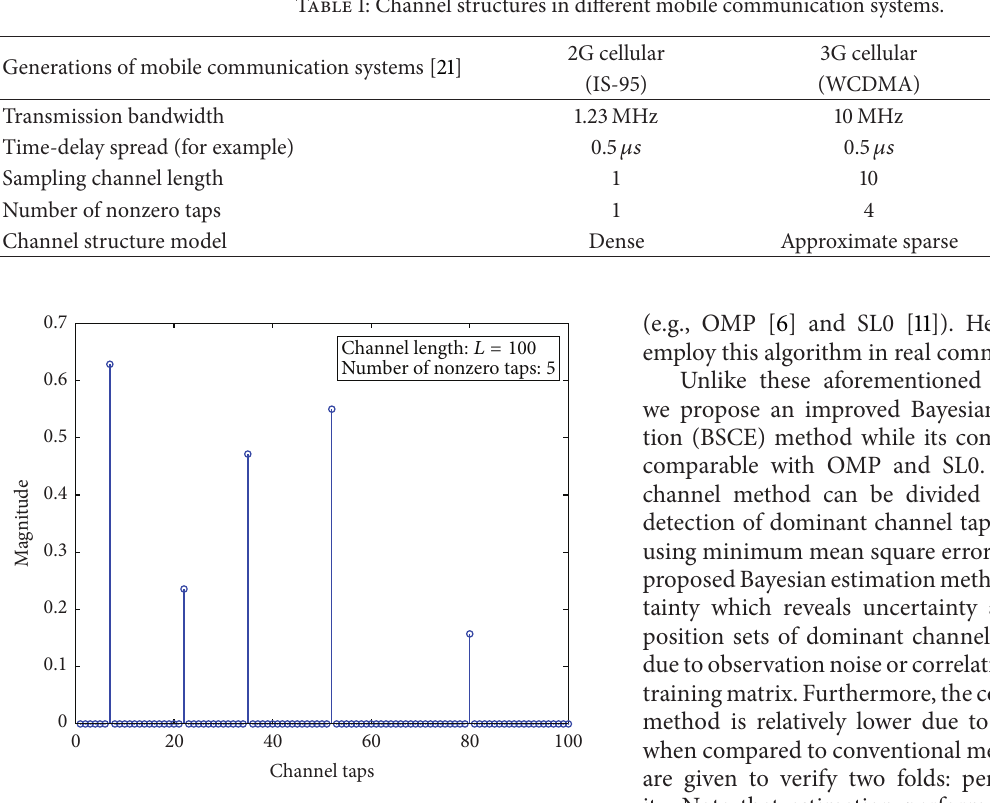
Figure 1: A typical example of sparse multipath